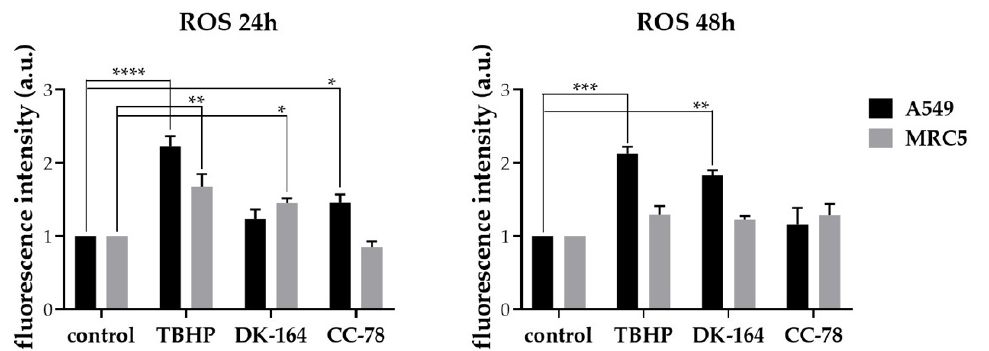
Figure 8. Reactive oxygen species (ROS) were induced by DK-164 and CC-78 in A549 cells and MRC5 cells. Cells were treated with IC25 of DK-164 and CC-78 for 24 h or 48 h, and ROS were measured using the DCF-DA microtiter plate assay. Tert -butyl-hydroperoxide (TBHP) was used as a positive control. Data represent the mean from three independent experiments, where each experiment was performed in triplicate. Probability values were considered significant at the * p < 0.05, ** p < 0.01, *** p < 0.005, and **** p ≤ 0.001. The error bars represent the standard deviation (SD). a.u.: arbitrary unit.